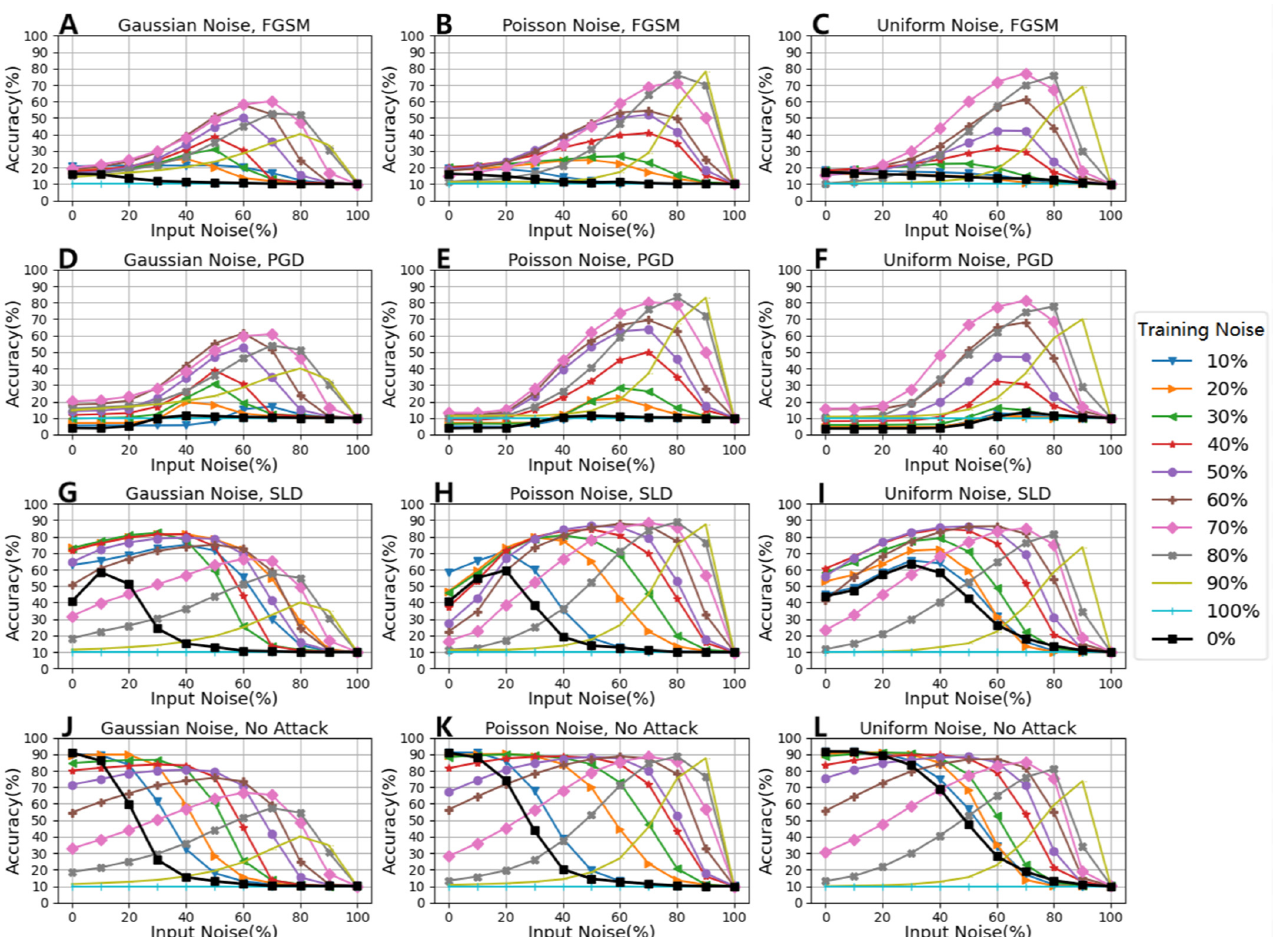
Figure 6. Accuracy of the CIFAR-10 at input noise dimension. The x axis is the input noise ampli- tude, and the y axis is the accuracy. Different color curves with various symbols indicate different amplitudes of training noise. Table 1. Accuracy of adversarial training and the NFM on the MNIST and CIFAR-10.